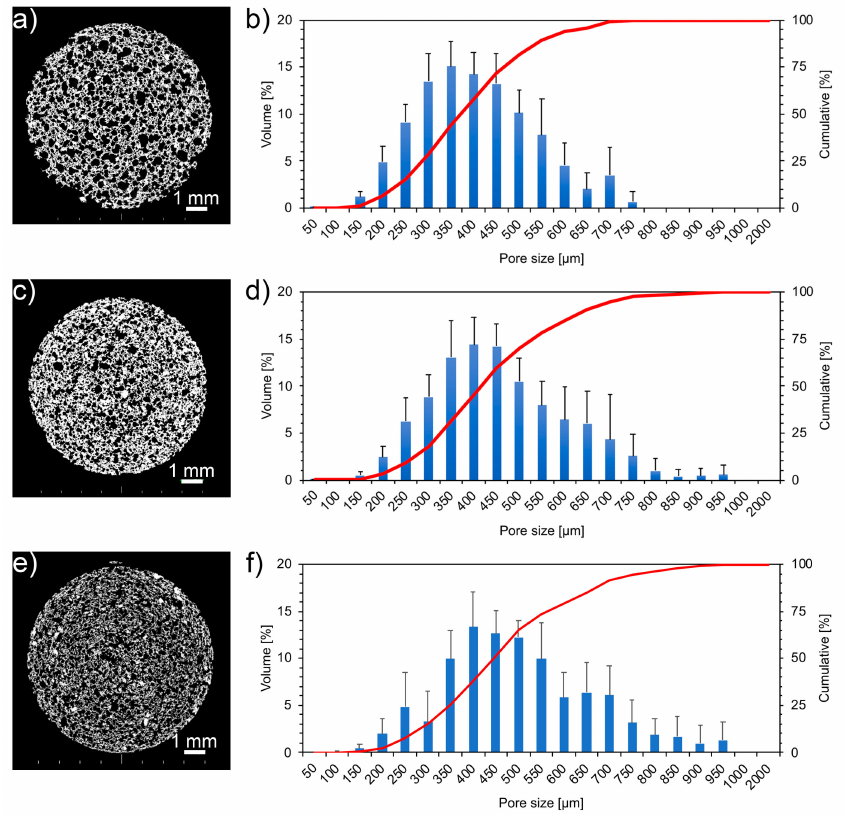
Figure 5. Computed micro-tomography and pore size distribution evaluated through Clemex image